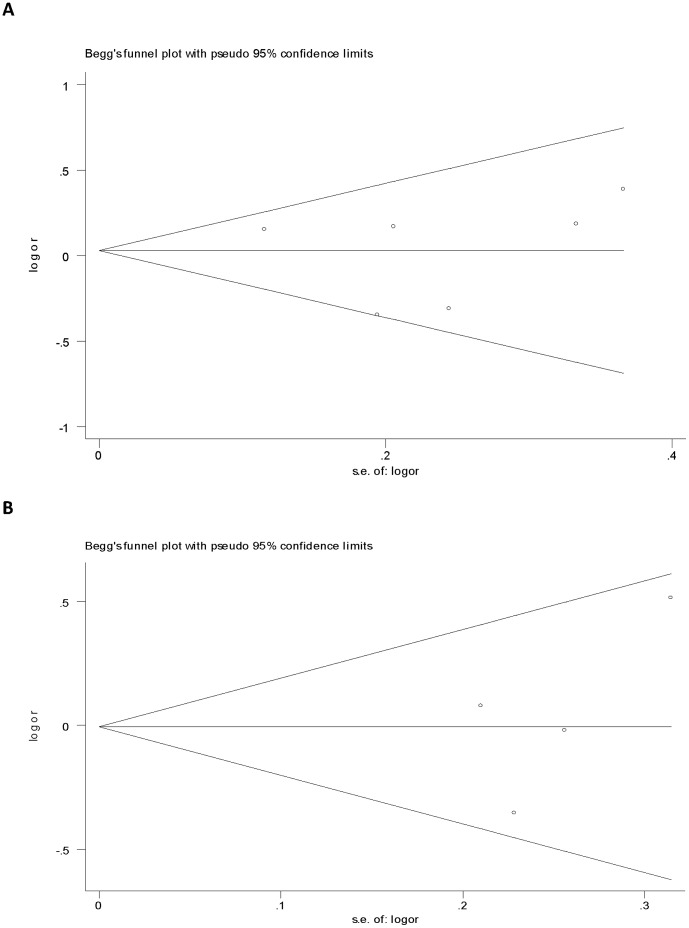
Begg's funnel plot of publication bias for rs11614913 and rs3746444.A. Begg's funnel plot for rs11614913(C versus G). B. Begg's funnel plot for rs3746444 (A versus G). Log OR is plotted versus standard error of Log OR for each included study. Every circle dot represents a separate study for the indicated association by allele contrast.